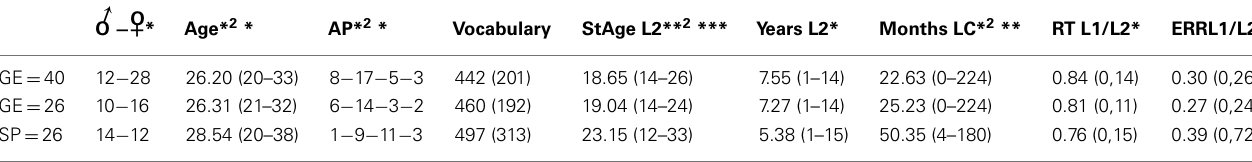
Table 1 | Means (ranges, or SD) for measures of second language proficiency for the group of native Spanish speakers (SP = 26), for the complete sample of German native speakers (GE = 40) and for a matched Sub-sample of German native speakers (GE =